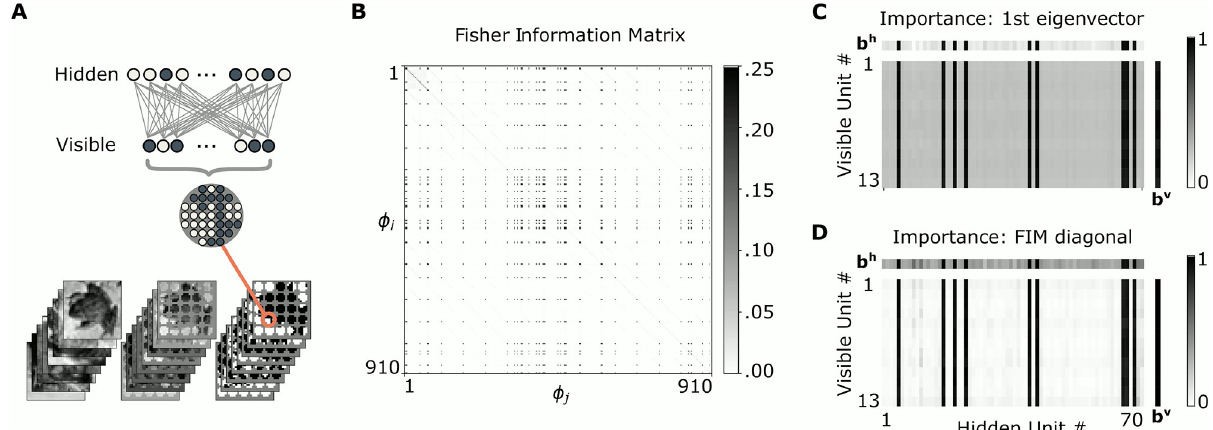
Fig 1. Model architecture and visualization of Fisher information. (A) Preparation of dataset and general model architecture: circles of different radii were sliced out of CIFAR-10 images and binarized. The pixels corresponded to the visible units of a standard RBM with one hidden layer. (B) Fisher information for an exemplary over-parameterized RBM initialized with n = 13 visible units and n = 70 hidden units. The FIM is sparse, indicating v h many irrelevant parameters. (C) Importance of each parameter, as summarized by the value for each parameter in the vector of steepest curvature in the FIM (i.e. the leading eigenvector). The rectangular plot shows the normalized importance for all weights w ij connecting visible units ( v i ; vertical axis) ; horizontal axis). The importance for biases for the hidden ( b h ) and visible ( b v ) units is shown above (horizontal) and to the right and hidden units ( h j (vertical), respectively. (D) Normalized parameter importance directly estimated from the diagonal entries of the FIM. (FIM = Fisher Information